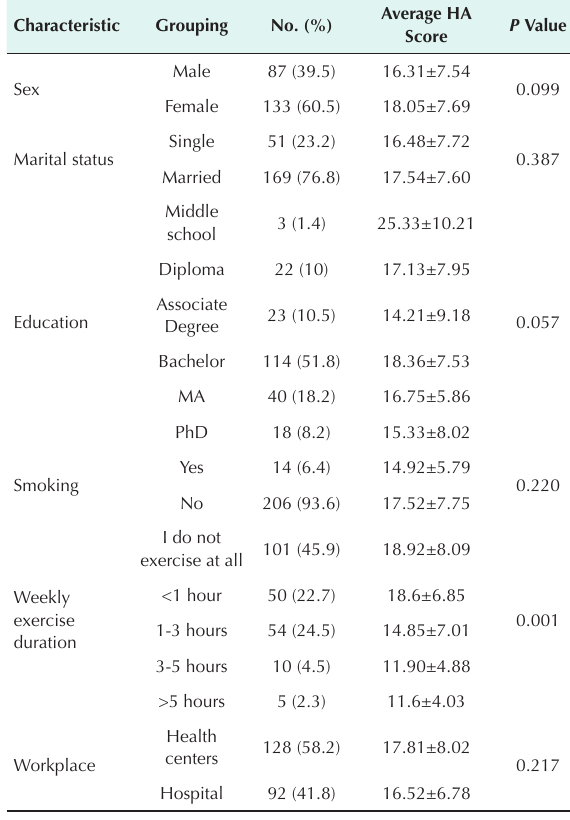
Table 1 . Demographic Characteristics and Mean HA Score of the Participants